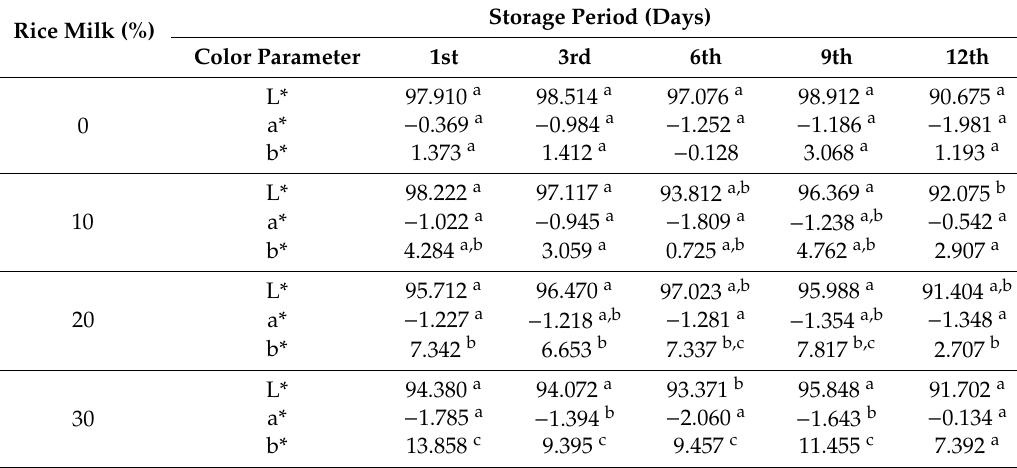
Table 3. Changes of color of paneer during the storage